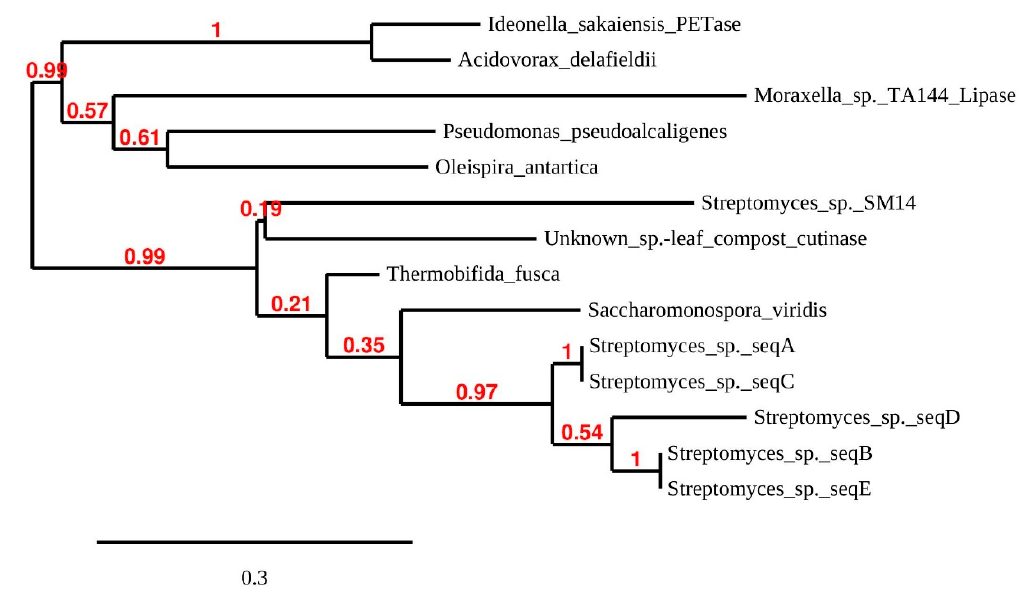
Figure 3. Maximum likelihood phylogenetic tree of putative PET-hydrolyzing enzymes and some structural homologs. The tree is based on sequences aligned in Figure 2 and additional ones: Streptomyces sp. SM14 (from a marine sponge) alpha/beta hydrolase (DAC80635). Unknown species: leaf compost cutinase (G9BY57). Moraxella sp. lipase (P19833) for rooting of the tree. Tree branch support values are shown in red at the nodes. The scale bar indicates the average number of amino acid substitutions per site.